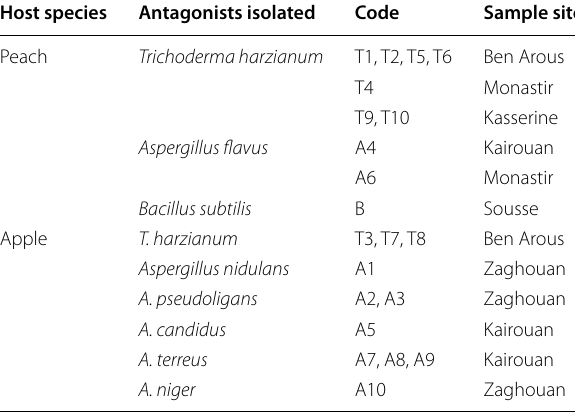
Table 2 Antagonists used to control growth of Fusarium and Pythiaceous species associated with peach decline seedlings in the Tunisian